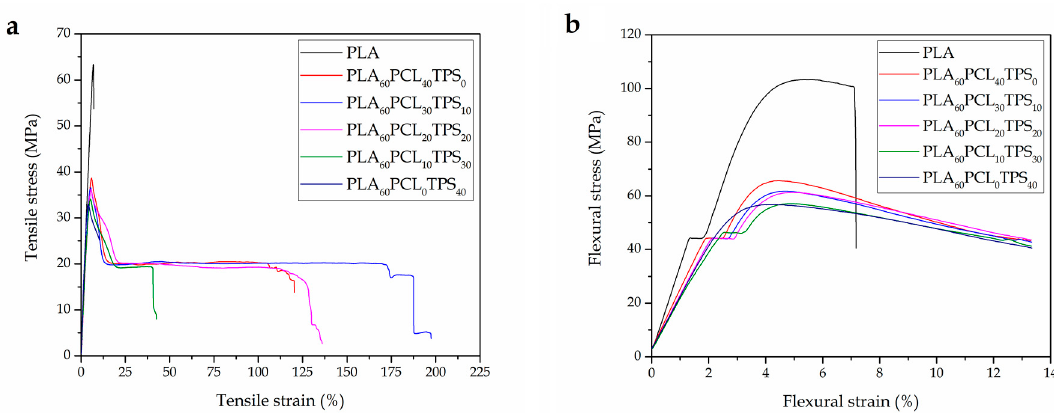
Figure 1. Stress–strain curves of the polylactide (PLA), poly( ε -caprolactone) (PCL), and thermoplastic starch (TPS) blend pieces obtained from: ( a ) tensile test; and ( b ) flexural test.